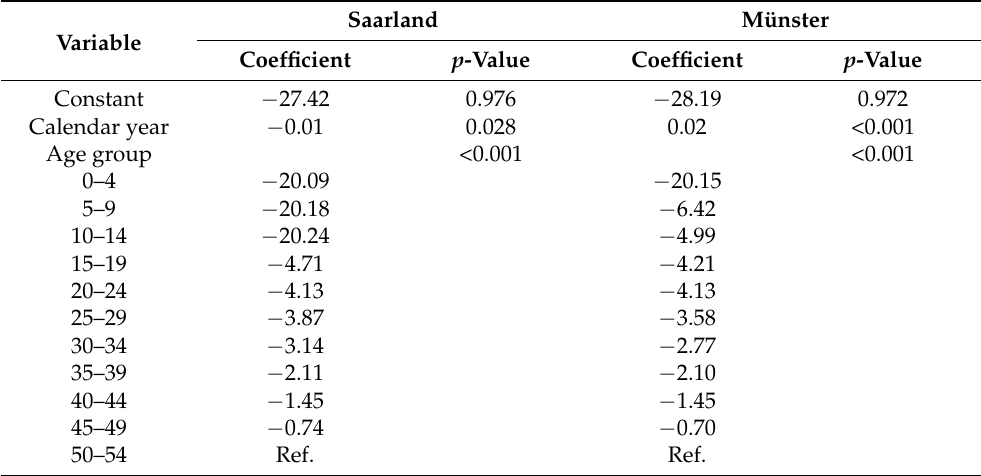
Table A2. Poisson regression for modeled incidence rates displayed in Figure 1, young-onset CRC.